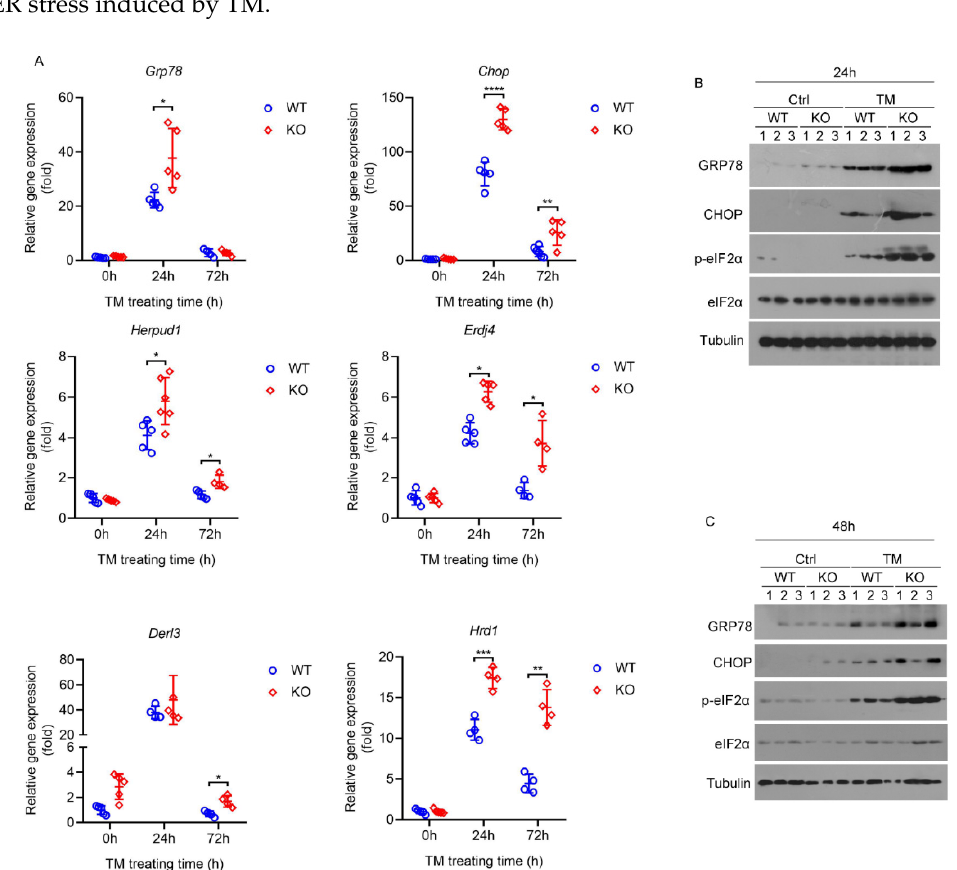
Figure 5. Deletion of HPS sensitizes mice to severe hepatic ER stress induced by TM. Eight-week-old WT and HPS-KO mice were injected intraperitoneally with TM (1 mg/kg body weight). ( A ) Relative expression of ER stress gene ( Grp78 , Chop , Derl3 , Hrd1 , Herpud1 and Erdj4 ) mRNA in liver